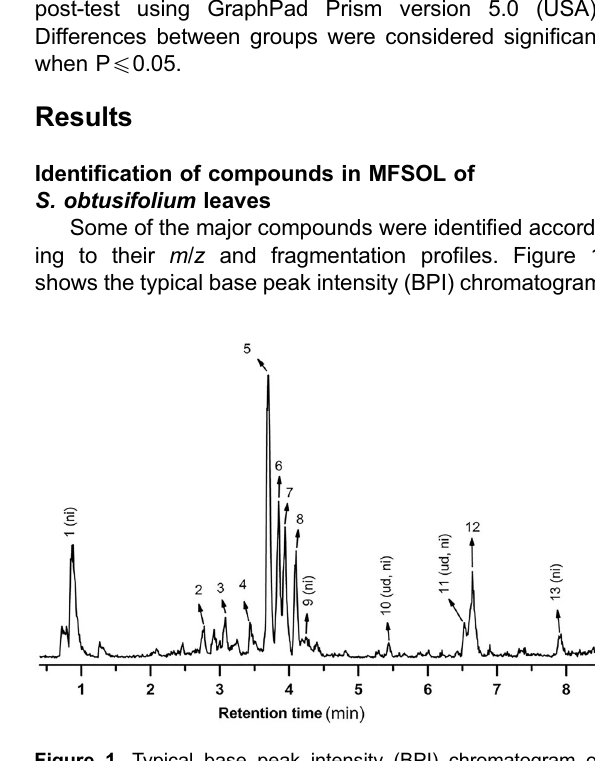
Figure 1. Typical base peak intensity (BPI) chromatogram of methanol fraction from leaf decoction of Sideroxylon obtusifolium (MFSOL) in the negative ionization mode. ni: not identi fi ed; ud: up to 1000